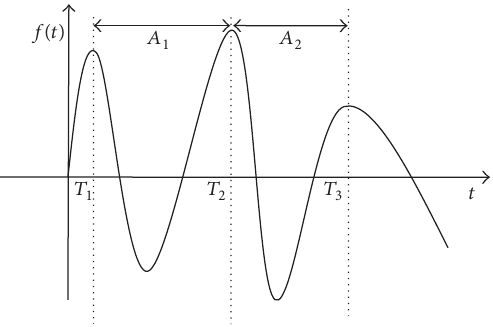
Figure 2: The dynamical definition of the SEs’